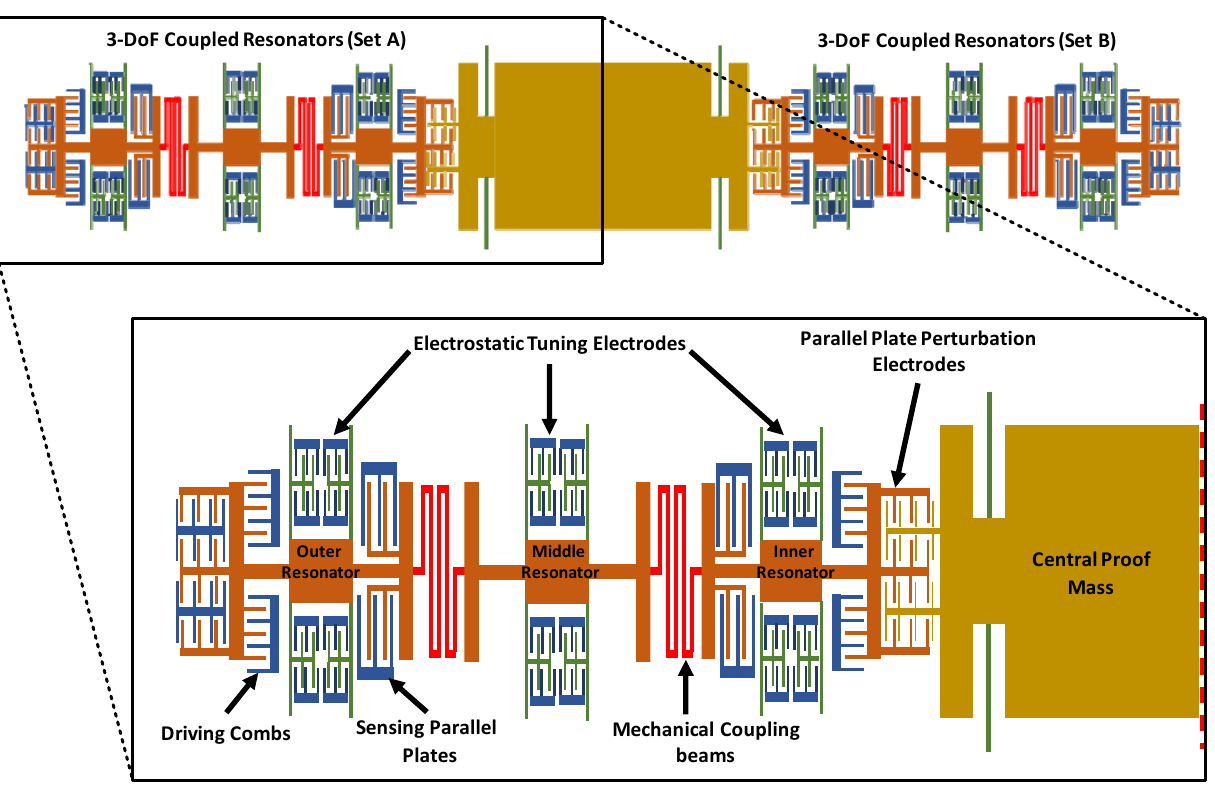
Figure 1. The structural design of mode-localized MEMS accelerometer with two sets of 3-DoF weakly coupled resonators on either side of central proof mass.